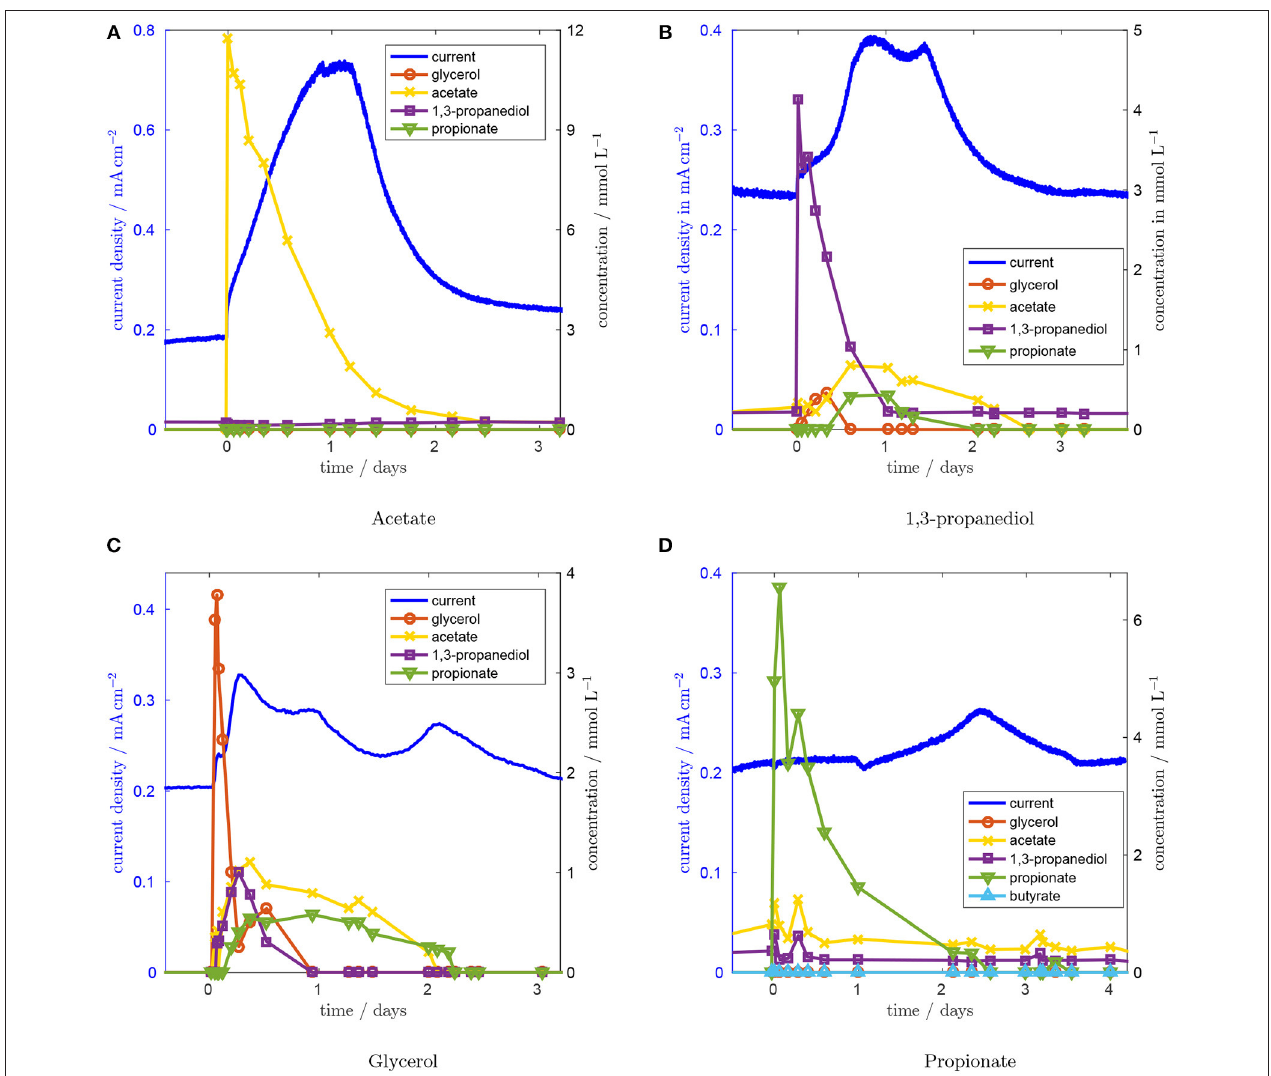
FIGURE 3 | Concentration and current responses to an acetate (A) , a 1,3-propanediol (B) , a glycerol (C) , and a proprionate (D) concentration pulse at t = 0. Residence time is 28.8h, glycerol inlet concentration 1.8mM, anode potential